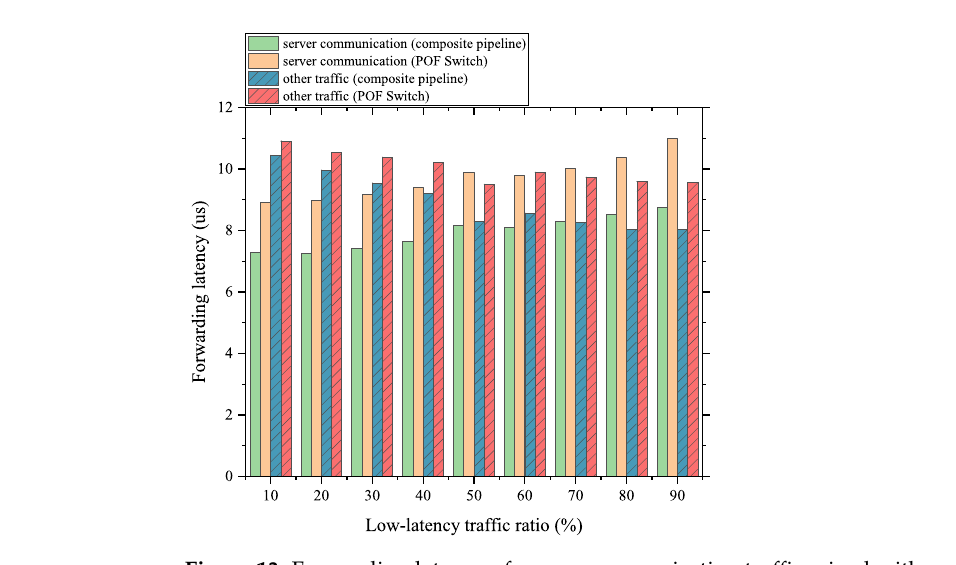
Figure 13. Forwarding latency of server communication traffic mixed with normal traffic.